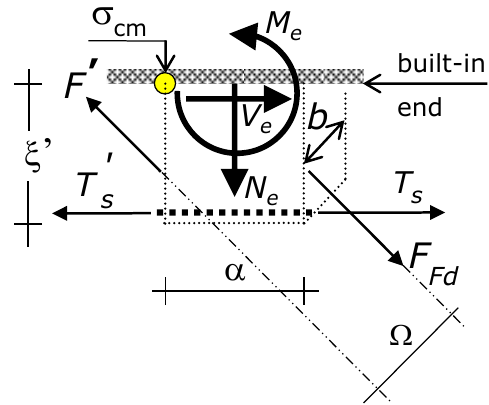
Figure 6. Forces applied to the concrete cantilever, internal actions, and maximum stress. The steel longitudinal bars and the side-bonded reinforcement induce the internal actions M e , N e , and V e at the built-in end of the concrete cantilever. At debonding, M e and N e induce the maximum tension stress σ cm , which is shown in the figure, including the point where it occurs (shadowed